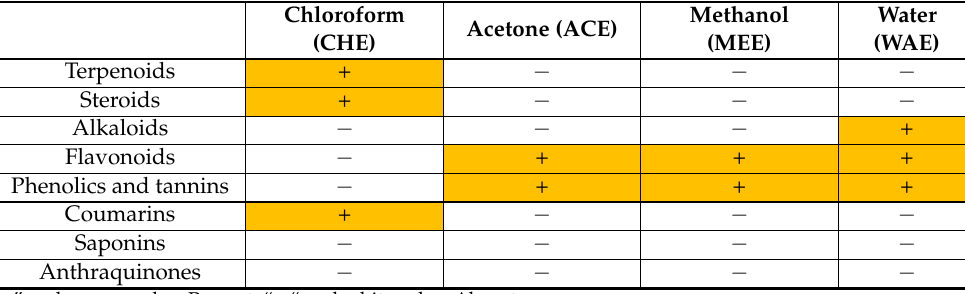
Table 1. Qualitative phytochemical analysis of five P. granatum bark (PGP) extracts. Chloroform Methanol Water Acetone (ACE) (CHE) (MEE) (WAE) Terpenoids + − − − Steroids + − − − Alkaloids − − − + Flavonoids − + + + Phenolics and tannins − + + + Coumarins + − − − Saponins − − − − Anthraquinones − − − − “+” and orange color: Present; “ − “ and white color: